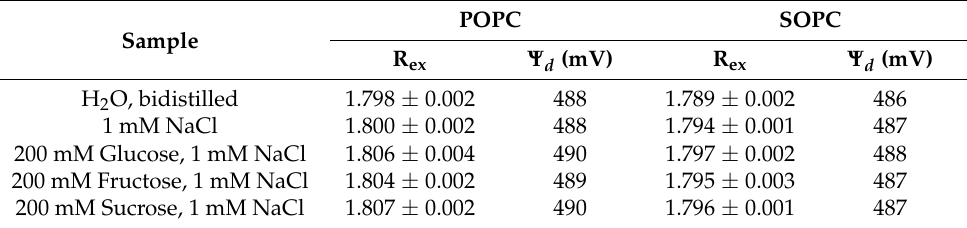
Table 3. Di-8-ANEPPS fluorescence intensity ratio and dipole potential of POPC bilayers in